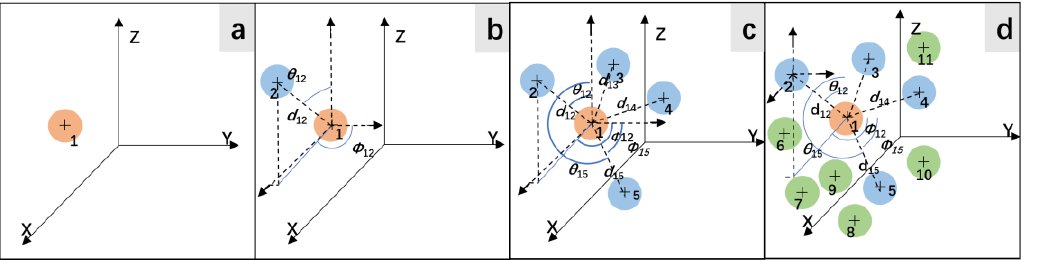
Figure 3. Schematic diagram of the improved NNA algorithm. ( a – d ) show the generation flow diagrams of the improved NNA